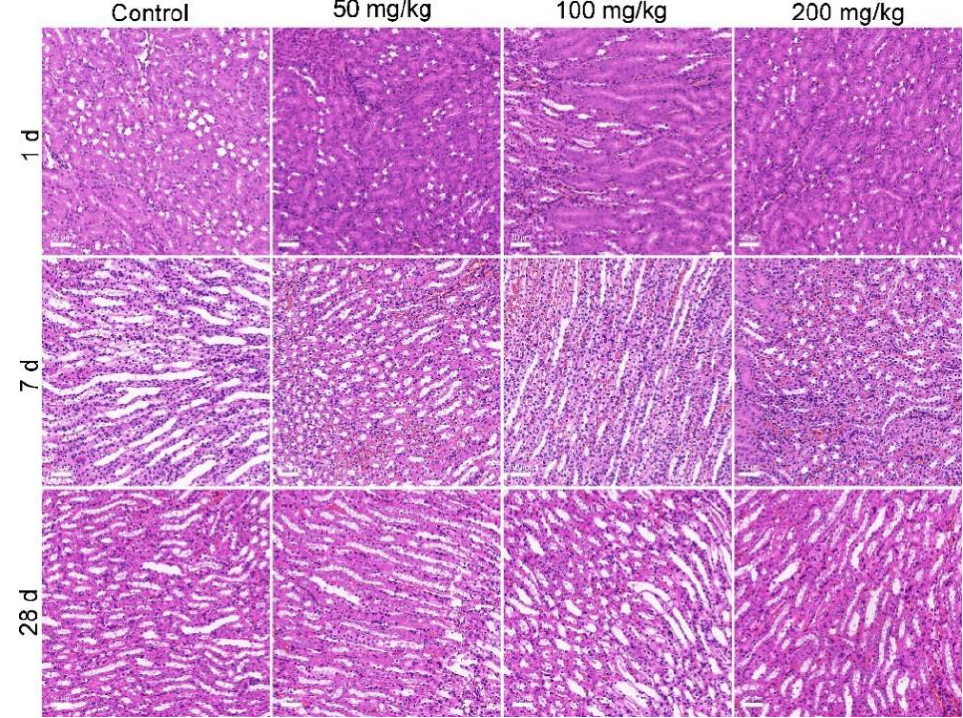
Figure 5. Histopathological observations of the liver after exposure to MOF-74(Co). The scale bar represents 50 μ m.